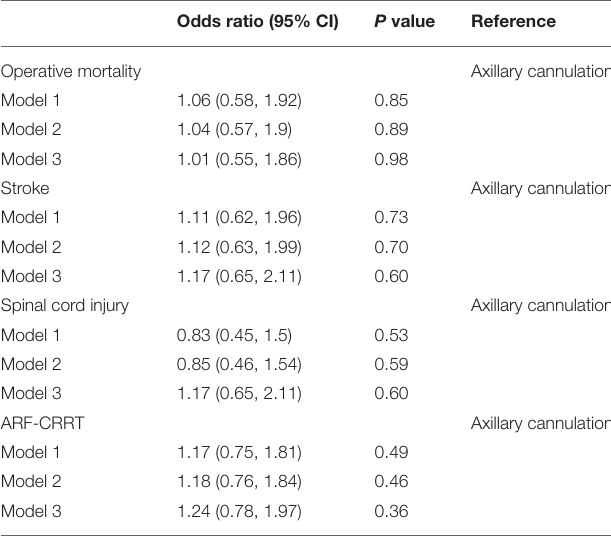
TABLE 4 | Multivariable analyses of operative mortality, stroke, spinal cord injury, and acute renal failure requiring CRRT for dual arterial cannulation vs. single axillary artery